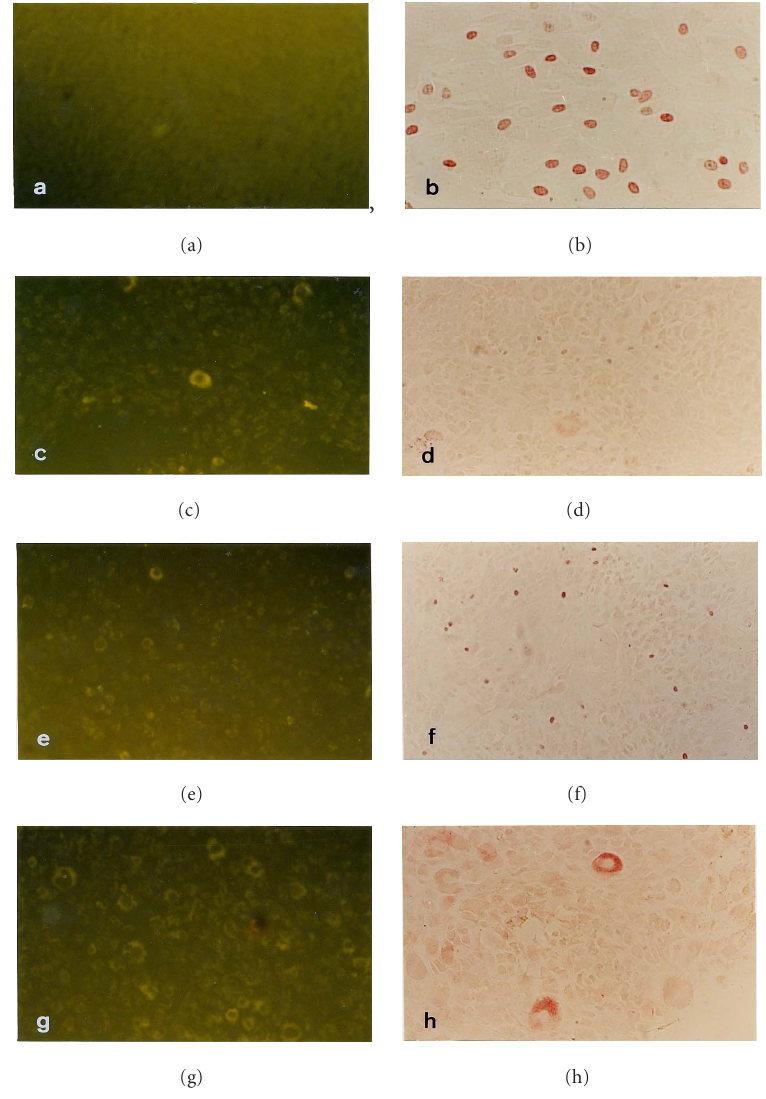
Figure 4. Detection of type-II collagen (left) and BrdU (right). (a), (b) Filtered cells. (c), (d) Addition of hyaluronan. (e), (f) Addition of sugar extract. (g), (h) Addition of small protein